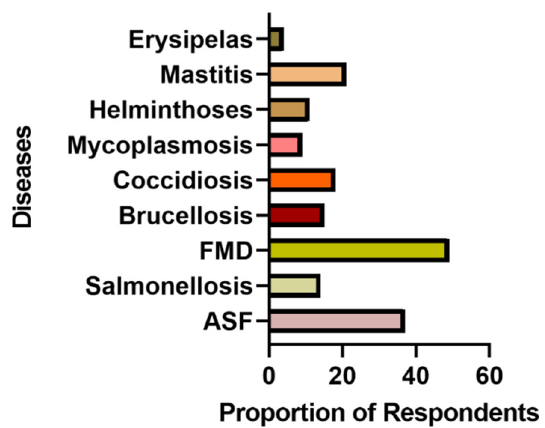
Figure 3. Common diseases self–reported by respondents during the survey. FMD: foot-and-mouth disease; ASF: African swine fever.